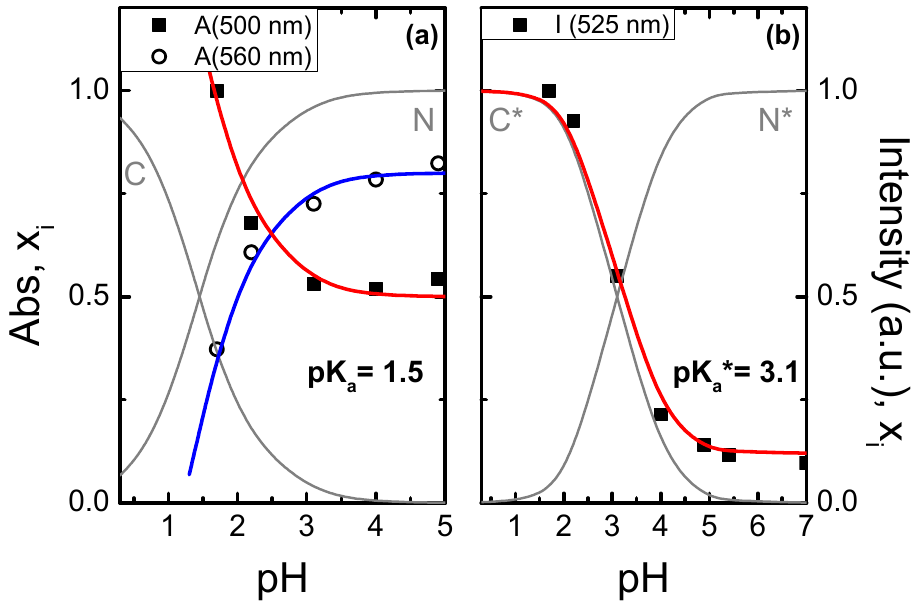
Figure 4. ( a ) Absorption and ( b ) steady-state fluorescence emission titration curves for BODIPY 3 together with the best fits to the data. The absorption and emission intensities were normalized to be superposed to the molar fraction distribution of species, x i , the ground- and excited-state protonated (cationic, C) and neutral (N) species.